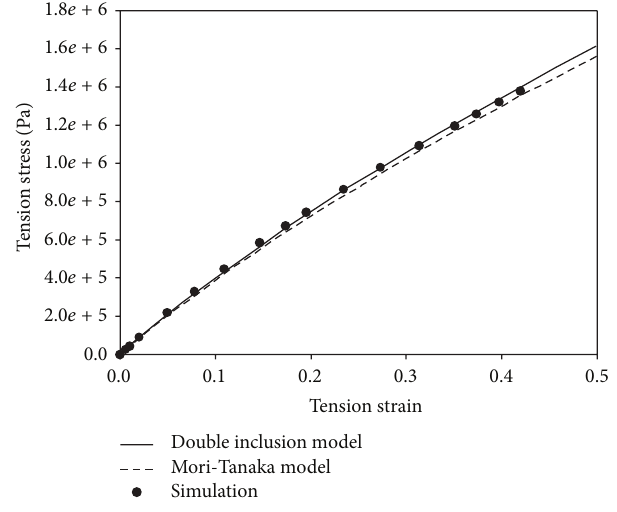
Figure 3: Stress-strain curve without a magnetic field.